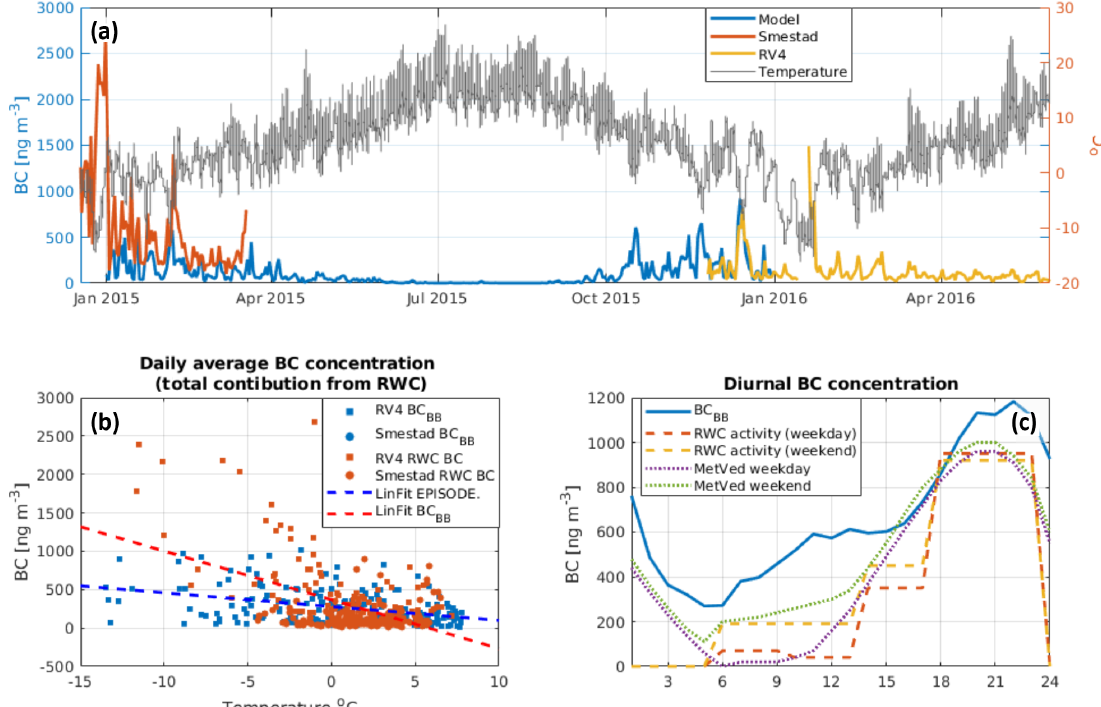
Figure 8. (a) The left y axis shows modelled RWC BC (blue) and measured BC BB data at Smestad and RV4 (in red and yellow respectively). The right y axis shows the time series of temperature at Blindern (grey). (b) Aethalometer concentrations of BC from wood burning against temperature measured at two sites in Oslo from winter 2015 to spring 2016 (red symbols) and EPISODE concentrations (RWC BC) in winter and spring for the calendar year of 2015 (blue symbols). (c) The diurnal profile of BC RWC averaged over winter 2015 to spring 2016 as measured by the Aethalometer (blue). The diurnal profile of firing habits as reported by wood consumers in Aasestad (2010) shown in dashed lines for weekdays and weekends (red dashed lines). The dotted lines show the diurnal variability in emission in